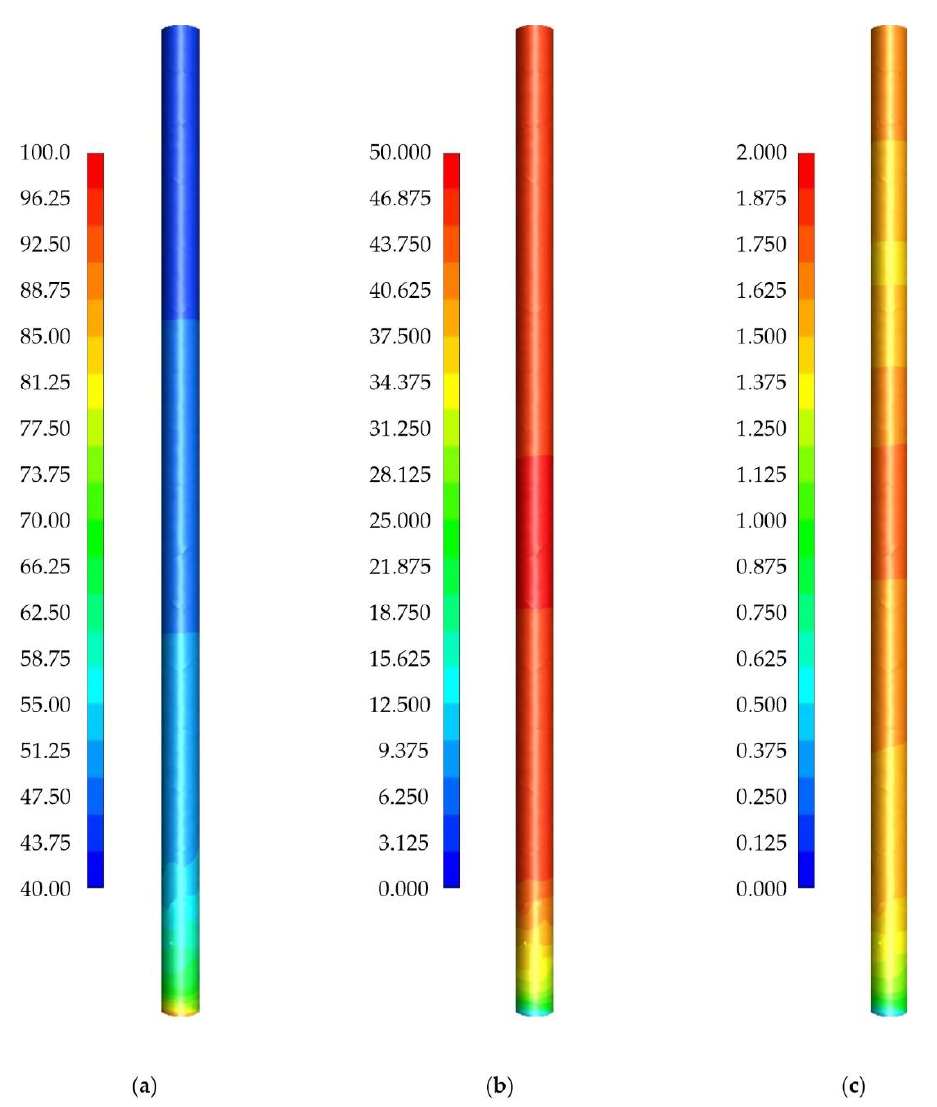
Figure 5. The mass fraction of isobutane dehydrogenation reaction products for the case of a catalyst mass of 100 g, a gas velocity of 0.016 m/s, and temperature of 575 °C: ( a ) C 4 H 10 ; ( b ) C 4 H 8 ; and ( c ) H 2 . Isobutane entered from the bottom of the reactor. Upon contact with the catalyst, the mass fraction of isobutane began to decrease to 52% of the mass fraction in the gas phase.